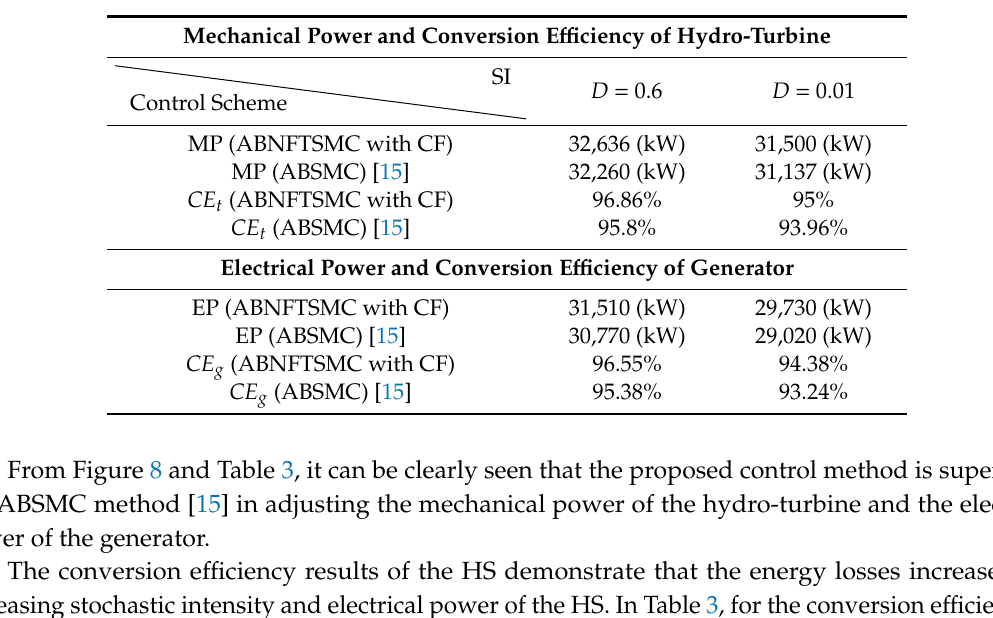
Figure 8. The comparison of power responses with different levels of stochastic intensity D . ( a ) mechanical power of hydro-turbine; ( b ) electrical power of generator. Table 3. The comparison of power conversion efficiency.